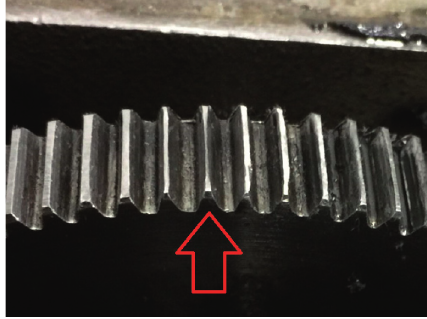
Figure 11: Tooth 36 after 800 hours of